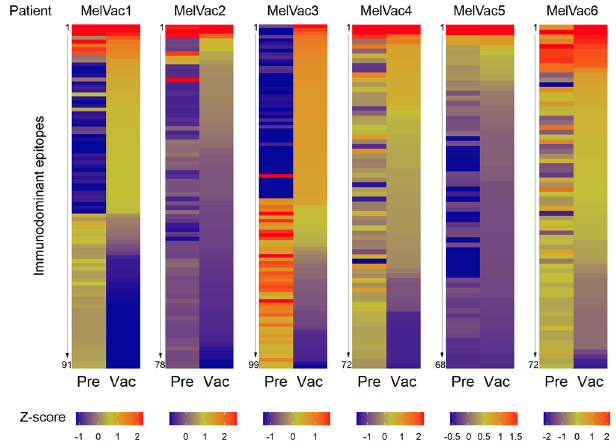
Fig. 2 The heterogeneity of antibody response converges on immunodominant epitopes. Heatmaps depict differential antibody response to the 50 most immunodominant epitopes detected in pre- ( Pre , n = 6) and post- ( Vac , n = 6) vaccination samples of patients who received MelCancerVac ® treatment ( MelVac1-MelVac6 ). Rows depict immunodominant epitopes with numbers on the left of each panel referring to the speci fi c epitope sequences provided in Supplementary Data 2. The number of epitopes differs for each patient as some epitopes were in the top 50 for both Pre and Vac samples, while some were detected in only one sample of the patient. Z-scores depict the abundance of IgG-binding peptides containing the immunodominant epitopes in each sample and are calculated separately for every patient by mean centering and autoscaling the abundance values across both Pre and Vac samples. Epitopes are ranked by highest-to-lowest abundance values as observed in the Vac sample. Z-score scale is cut-off at 97.5th percentile for better visualization of each